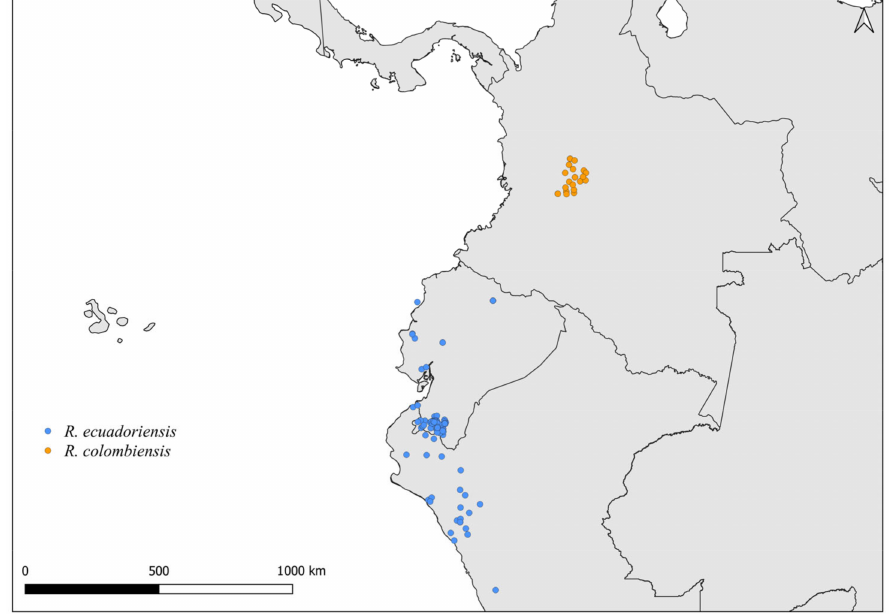
Figure 5. Distribution maps for R. ecuadoriensis and R. colombiensis .